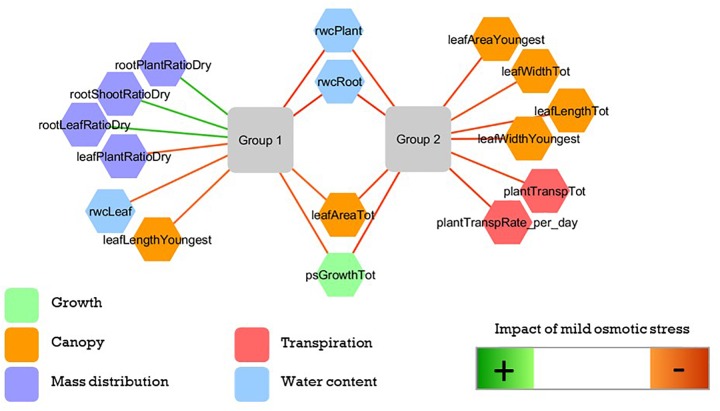
The variables most explanatory for the difference between stress and control derived independently in performance groups 1 and 2. Figure based on 11 cultivars from performance classes 1 and 2. Green connecting lines indicate that the variable is increased in mild osmotic stress compared to control, red lines indicate a decreased value.